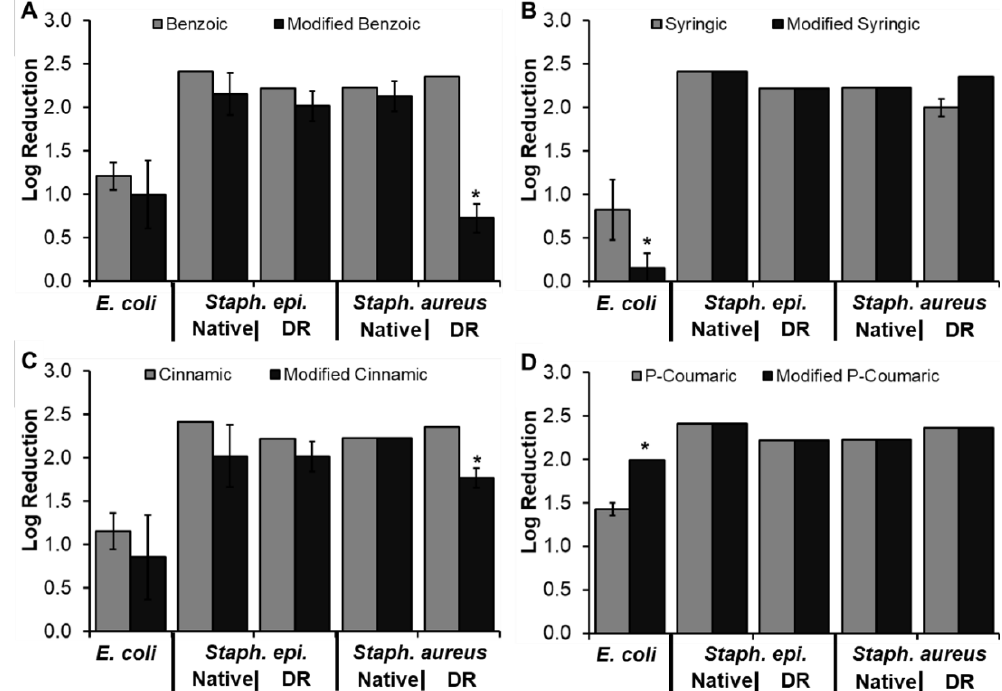
Figure 8. Antimicrobial properties of modified ( A ) benzoic, ( B ) syringic, ( C ) cinnamic, and ( D ) P-coumaric acids in comparison to their unmodified controls. Antimicrobial properties were quantified by log reduction in colony forming unit counts. * p < 0.05 relative to unmodified control. n = 3, mean ± standard deviation displayed.